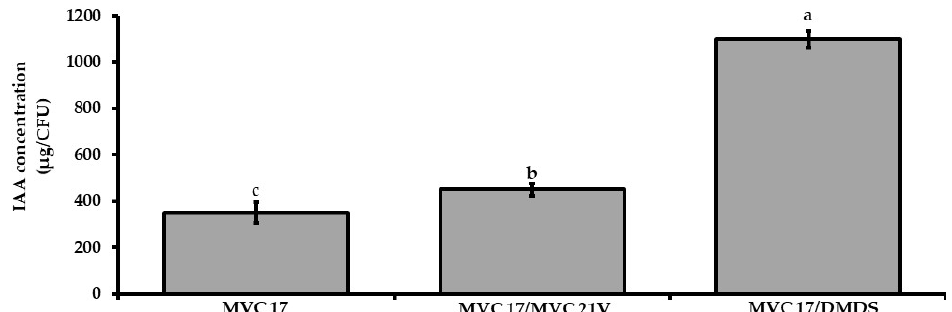
Figure 4. Effect of interaction mediated by volatile organic compounds (VOCs) on indol-3-acetic acid production by Pseudomonas ( Ps .) putida MVC 17. The effect of VOCs emitted by P. agglomerans MVC 21 and of dimethyl disulfide (DMDS) on the ability of Ps. putida MVC 17 to produce indole-3-acetic acid (IAA) was assessed after 120 h of incubation in DF salt amended with L-Tryptophan. MVC 17 alone. IAA production of Ps. putida MVC 17 grown alone; MVC 17/MVC 21V. IAA production of Ps. putida MVC 17 exposed to P. agglomerans MVC 21 VOCs. MVC 17/DMDS. IAA production of Ps. putida MVC 17 exposed to DMDS at 0.02 mg/25 well plate. Columns represent mean ± standard error values of six replicates for each treatment. Data from two independent experiments were pooled. Different letters indicate significant differences among treatments according to Tukey´s test ( α = 0.05).